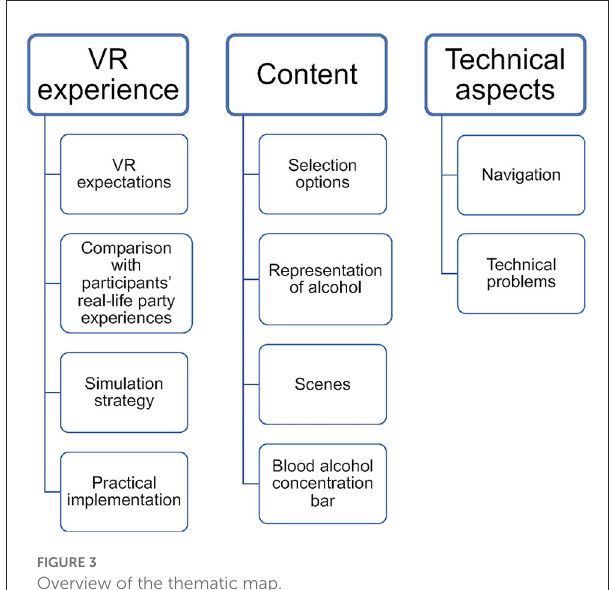
FIGURE3 Overview of the thematic map.